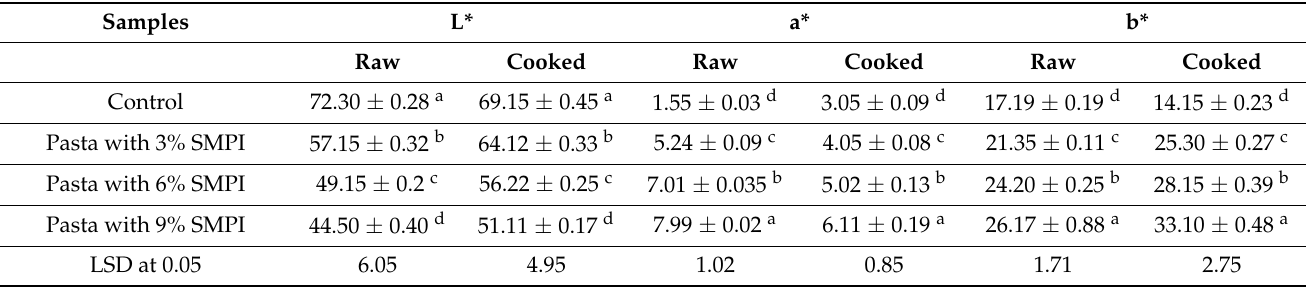
Table 5. Impact of mixing SMPI with wheat flour on the color parameter of